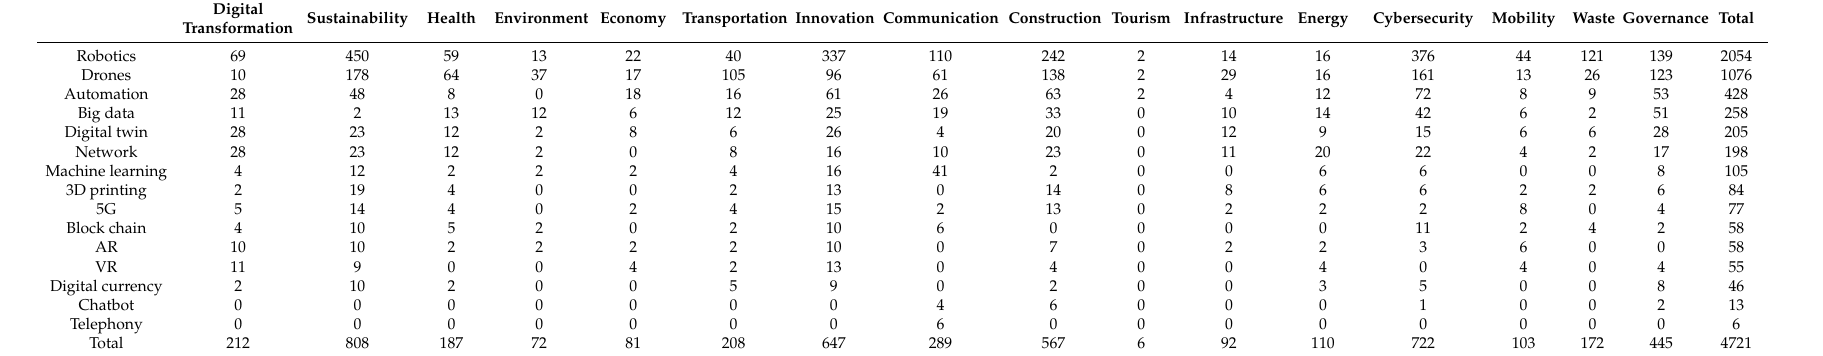
Table 7. Technology-concept relationship word co-occurrence analysis.